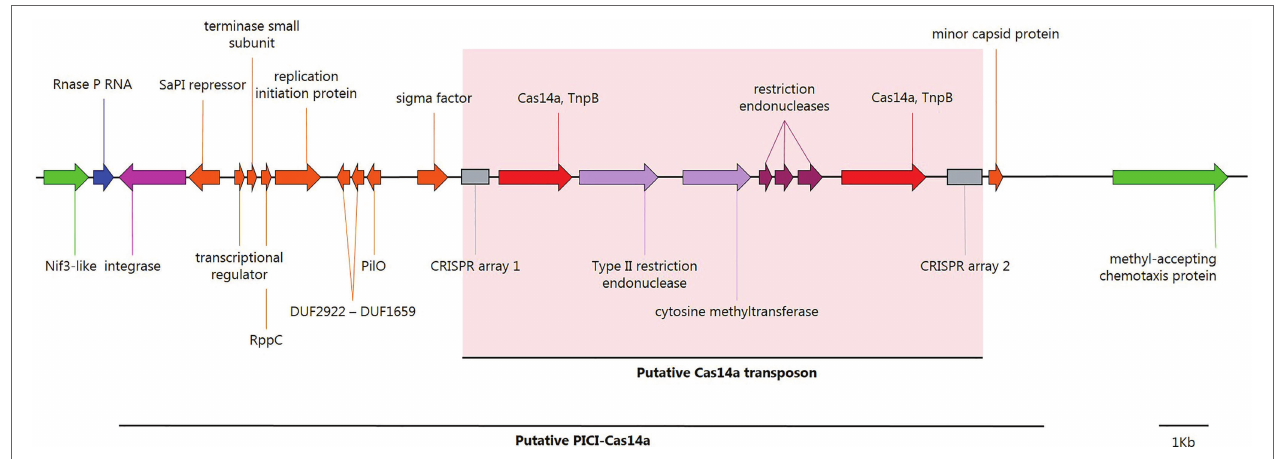
FIGURE 3 | Annotated map of genes in a putative genetic phage-inducible chromosomal island (PICI; C-Stockholm strain) from Clostridium novyi sensu lato lineage II. Nif3-like and the methyl-accepting chemotaxis proteins surrounding the PICI site of insertion in the C. botulinum C-Stockholm (NZ_CP063816.1) strain are shown in bright green; integration targeted RNase P ncRNA, recognized by the PICI integrase, blue; PICI tyrosine-recombinase integrase, pink; PICI-related CDS, orange; type V-U CRISPR Cas14a, red; CRISPR arrays, gray boxes; and restriction-modification related CDS, light purple, and dark red. This figure was created with